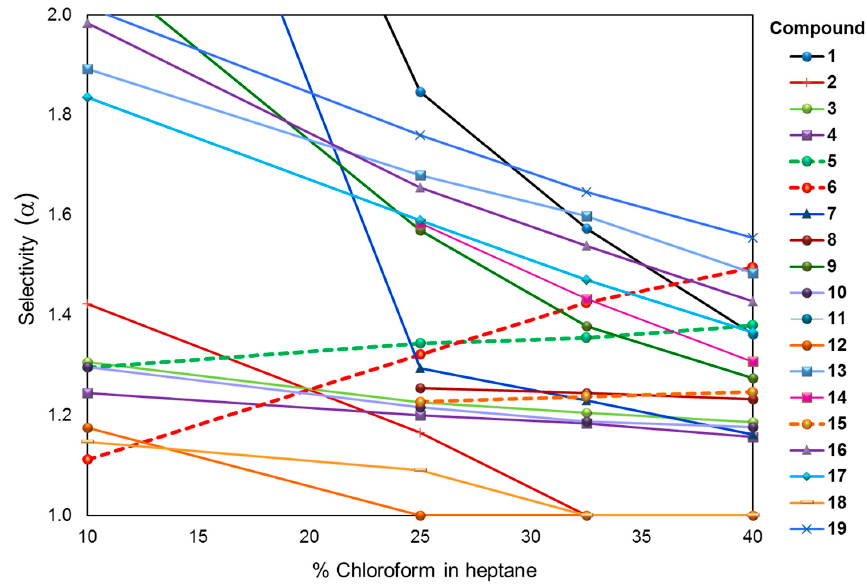
Figure 4. Chromatographic resolution of compound 1 – 19 on PMBC-Im E with heptane/chloroform as the mobile phase. Enantioselectivity vs. chloroform content in heptane.